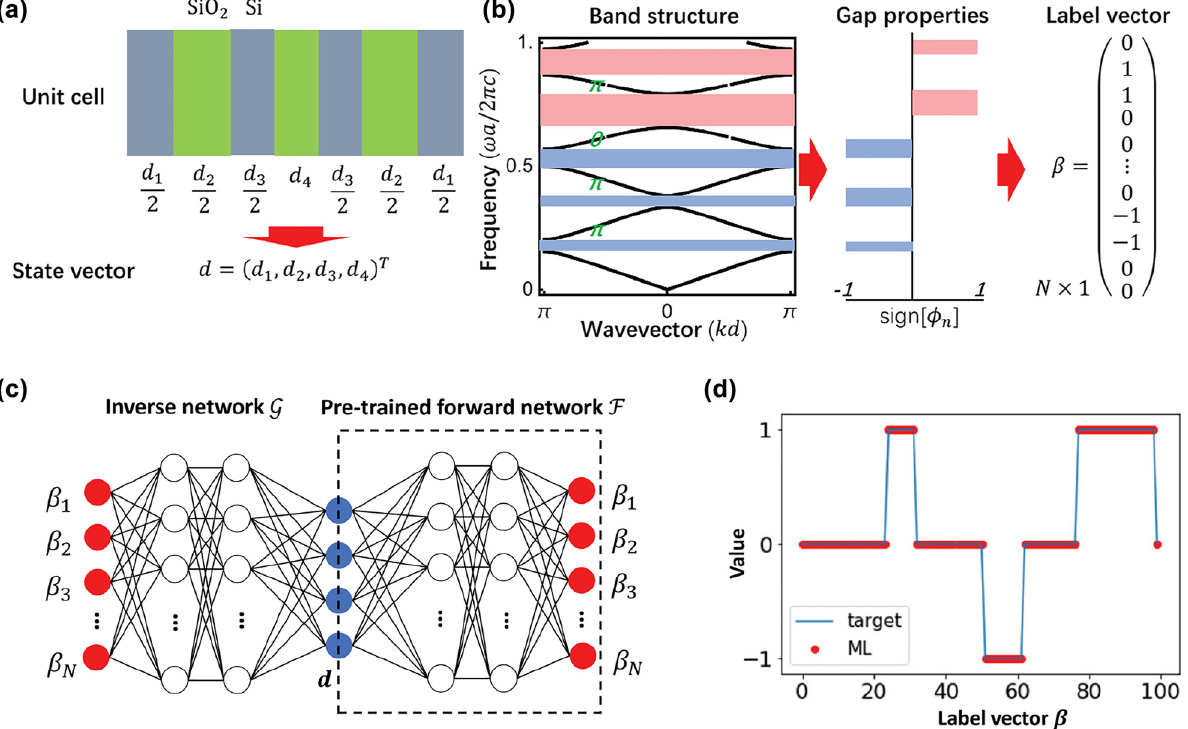
Figure 1: Inverse design of 1D photonic topological insulators using deep learning [93]. (a) The schematic of the state vector consisting of geometry parameters. (b) The schematic of label vector consisting of reflection phases. (c) The schematic of the tandem network. (d) The comparison between the reflection phases of the inverse-designed photonic crystal and the target reflection